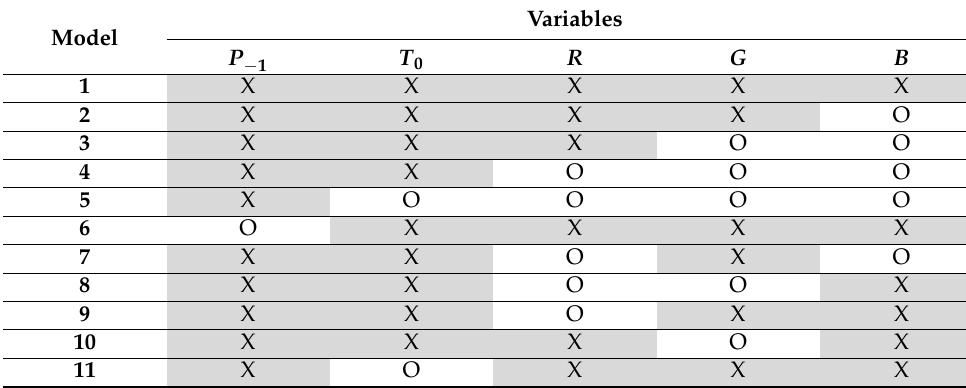
Table 5. Variables used in the second step of NN modeling.